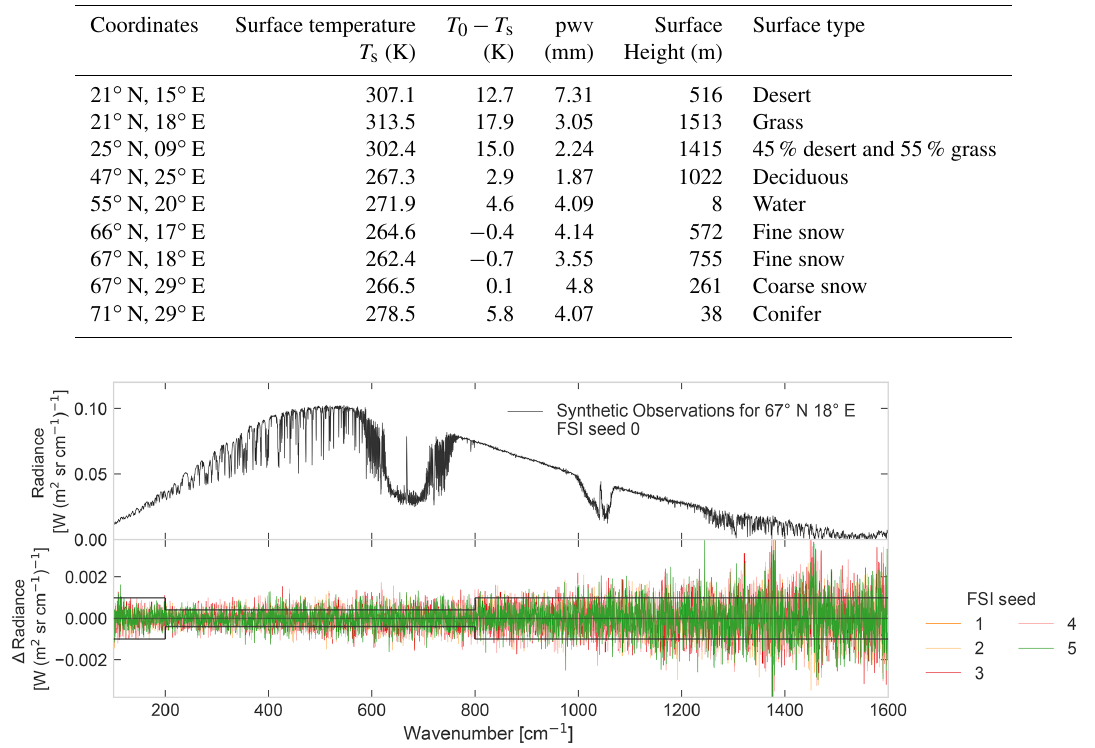
Table 1. Atmospheric and surface data for the various scenes used in this study. All data are for 15 January 2018 at 12:00:00UTC. Surface temperatures, surface heights, water vapour profiles and temperature profiles are from ERA5 reanalysis data. Surface types are fitted to the Huang et al. (2016) dataset, as detailed in the text. Note: pwv stands for precipitable water vapour, and T 0 − T s is the difference between the lowest point of the temperature profile and the surface temperature.